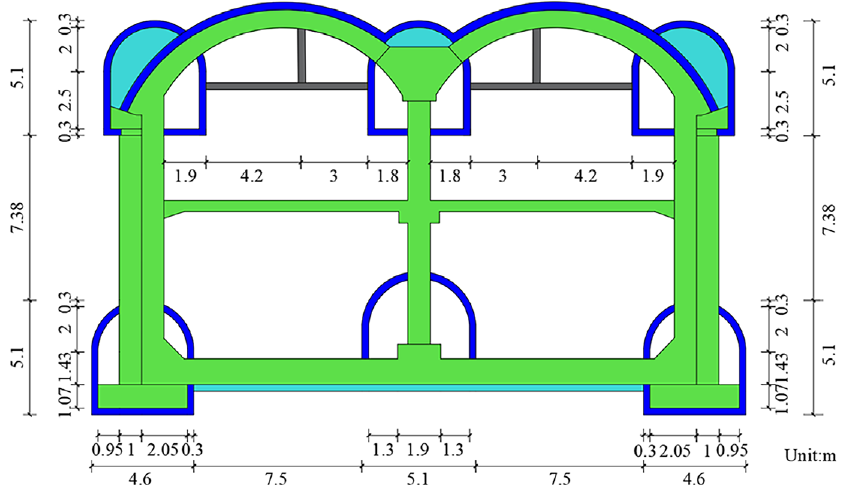
Figure 3. Cross - sectional dimensions of Qinghuadongluxikou Station.